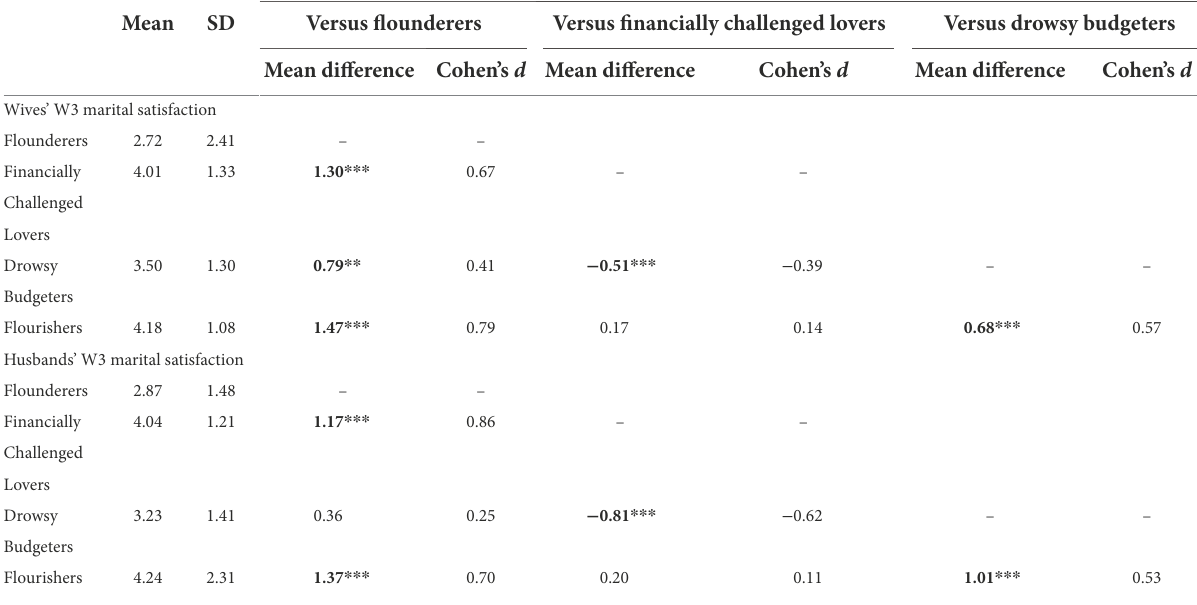
TABLE 4 Comparisons of W3 marital satisfaction between each latent profile (N = 1,001 couples). Mean differences between latent profiles Mean SD Versus flounderers Versus financially challenged lovers Versus drowsy budgeters Mean difference Cohen’s d Mean difference Cohen’s d Mean difference Cohen’s